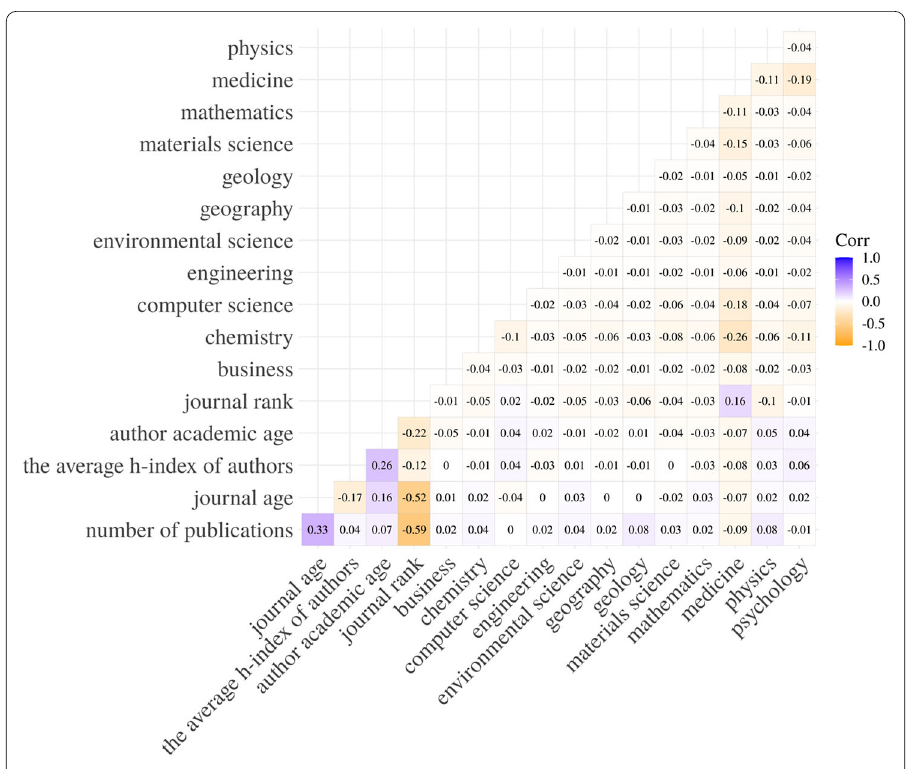
Figure 4 Correlation matrix of predictors. Only a few of predictors have a relatively high correlation between each other, such as journal age and journal